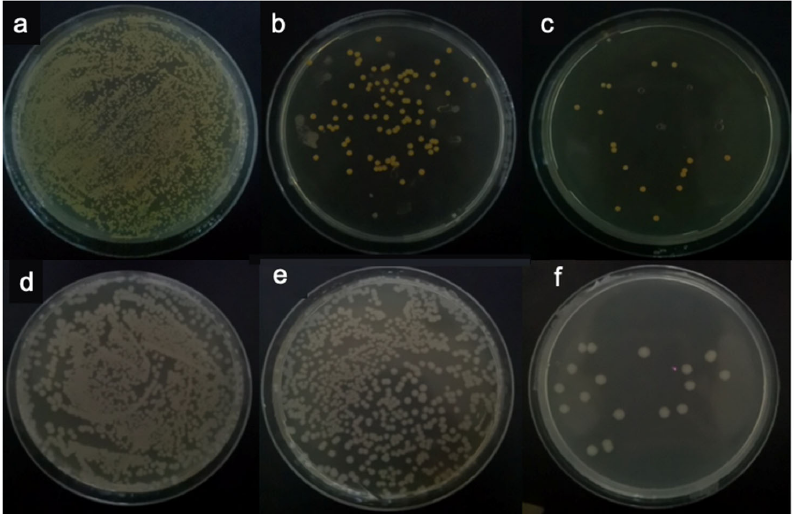
Figure 6. Colonies number of E. coli. ( a – c ) and S. aureus. ( d – f ) after incubation with CMCS ‐ GA ‐ gel and CMCS ‐ GA ‐ AgNPs. ( a , d ) are blank controls; ( b , e ) are the group incubated with CMCS ‐ GA ‐ gel. ( d , f ) are the group incubated with CMCS ‐ GA ‐ AgNPs.